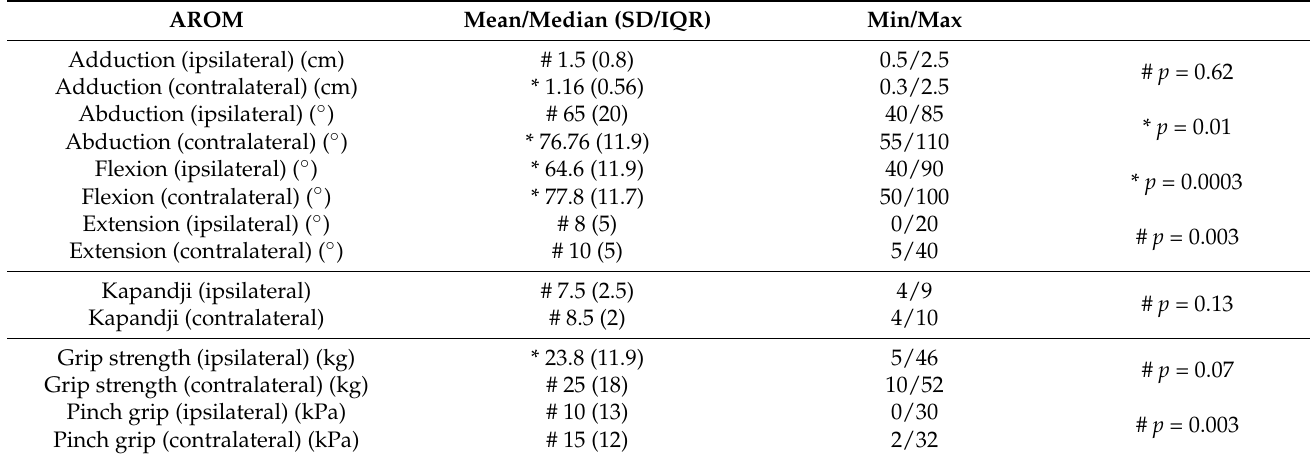
Table 2. Patient characteristics: AROM before